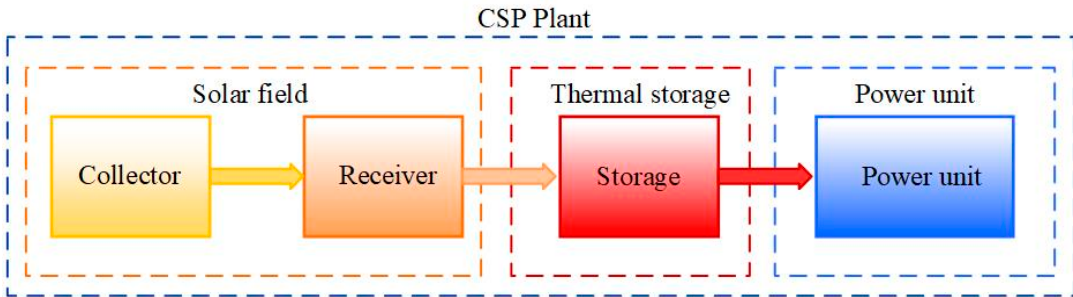
Figure 2. Principle of operation of a CSP plant.